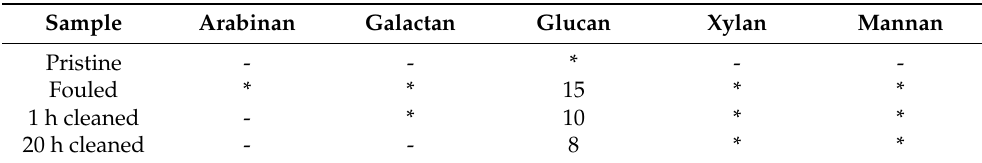
Table 1. Amount of polysaccharides (mg/m 2 ) found on the various membrane samples using high-performance anion-exchange chromatography coupled with pulsed amperometric detection (HPAEC-PAD). Sample Arabinan Galactan Glucan